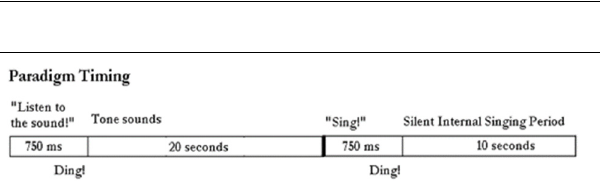
FIGURE 1 | Schematic of the neurotrophic electrode illustrates a hollow glass tip with 2 mil Teflon insulated gold wires glued inside. Trophic factors inside the glass tip entice neurites to grow inside as illustrated. Bipolar recording amplifier produces action potentials that depolarize according to the proximity of the recording wires.